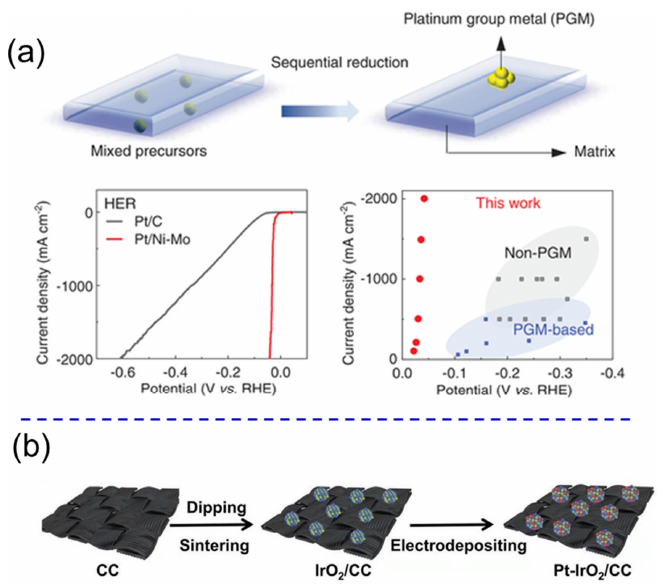
Figure 1. ( a ) The preparation schematic of Pt/Ni-Mo and its HER activity in alkaline seawater [15]; ( b ) illustration of the synthetic route of the Pt-IrO 2 /CC [18]. ( b ) illustration of the synthetic route of the Pt-IrO 2 /CC